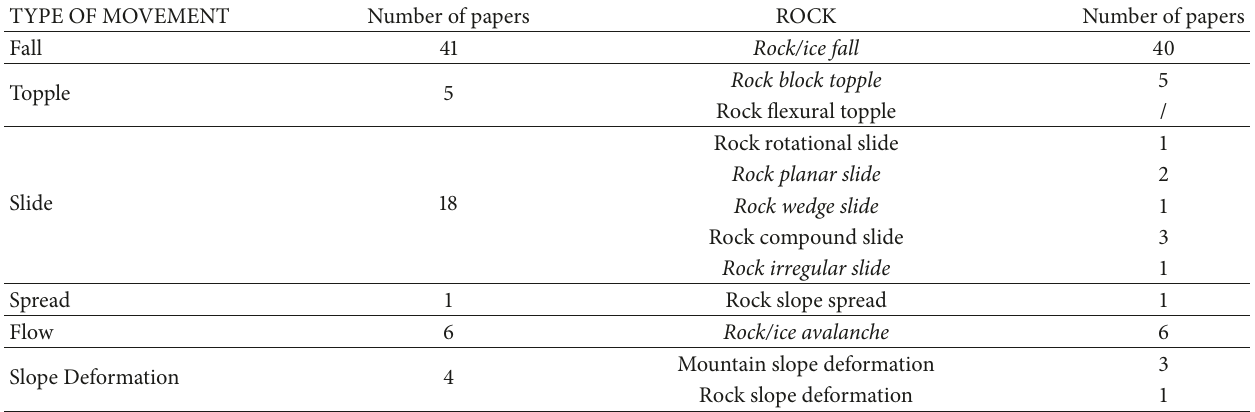
Table 6: For each movement type and “rock” landslide typology, the table summarizes how many papers are focused on it. In italic movement types that usually reach extremely rapid velocities as defined by [2], while for the others, the velocity varies between extremely slow to very rapid (for details, refer to [4]).